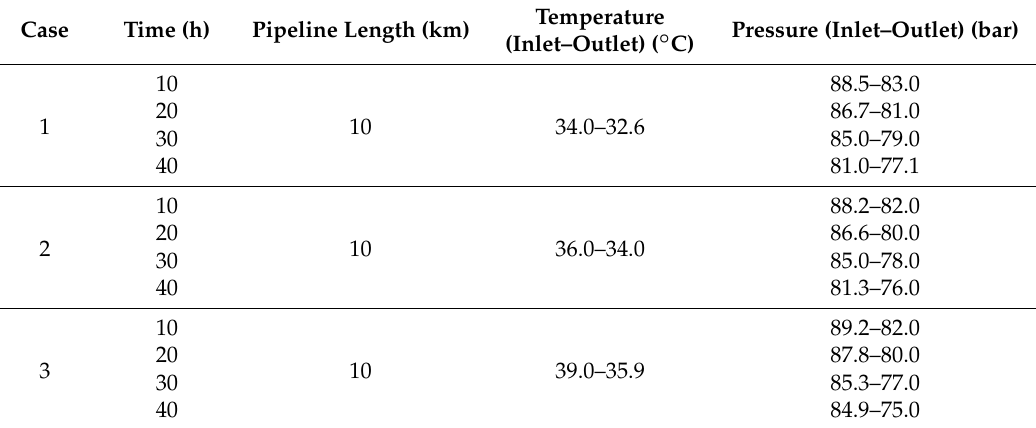
Table 4. Simulation conditions for each horizontal pipeline